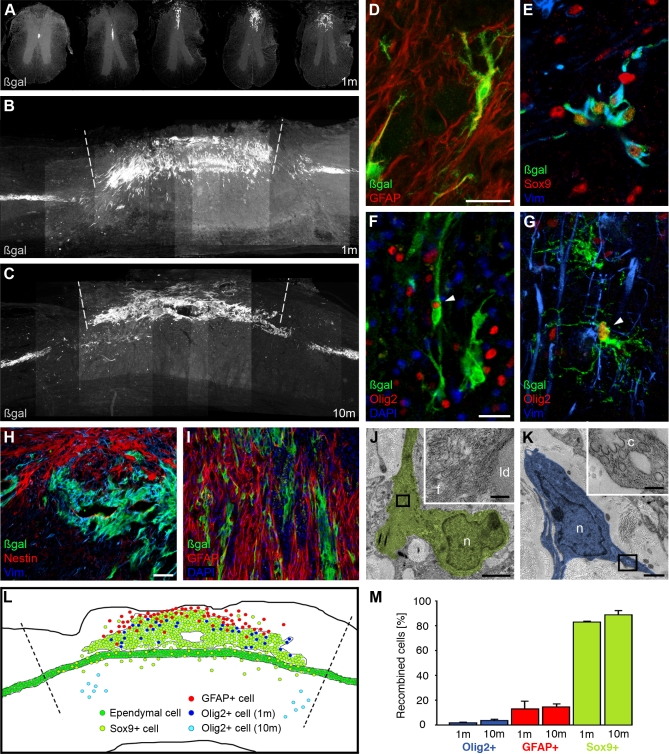
Ependymal Cells Contribute to Scar Formation after Spinal Cord Injury(A) Distribution of β-gal–immunoreactive ependyma-derived cells in coronal sections from an uninjured segment (left) further towards the lesion epicenter (right).(B and C) Sagittal sections show the distribution of recombined cells 1 mo (B) and 10 mo (C) after a dorsal funiculus incision (indicated by hatched lines).(D and E) Recombined cells outside the ependymal layer display either (D) the astrocytic marker GFAP or (E) a Sox9/vimentin double-positive profile.(F and G) Other recombined cells are Olig2 immunoreactive (arrowheads) and have oligodendrocyte morphology at later time points ([F] is at 1 mo and [G] 10 mo).(H and I) The scar tissue is compartmentalized with patches of ependyma-derived cells.(J and K) Electron micrographs of β-gal–immunoreactive cells with astrocyte (J) or oligodendrocyte (K) morphology. Boxed areas are shown at a higher magnification in the insets.(L) Drawing (based on [C]) depicting the distribution of recombined cells of different phenotypes.(M) Marker profile of recombined ependyma-derived cells (mean and SD from 3 mice at each time point) in the area encompassing the injury indicated by hatched lines in (L).c, caveolae; f, filaments; ld, lipid droplet; n, nucleus.Scale bars indicate 25 μm in (D–G) and (H), 50 μm in (I), 2 μm in (J), 1 μm in (K), and 0.15 μm in insets in (J) and (K).